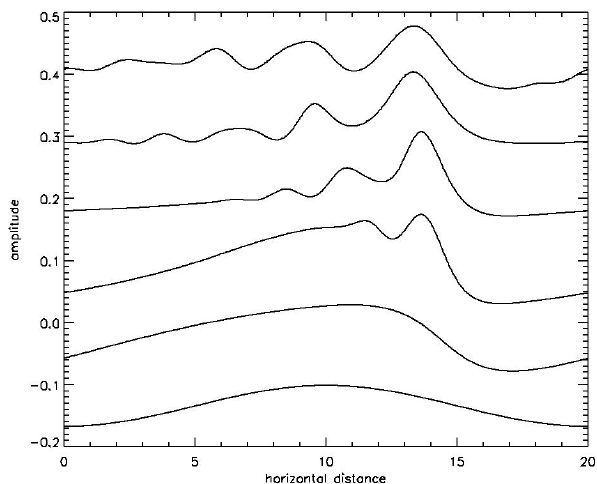
Fig. 3. Line plots through the contour plots depicted in Fig. 2. All cuts were taken at z = − 0.34. The lowest trace corresponds to panel (a) of Fig. 2. Each trace has a constant offset added to it for clarity ending with the top trace which is a cut through panel (f).